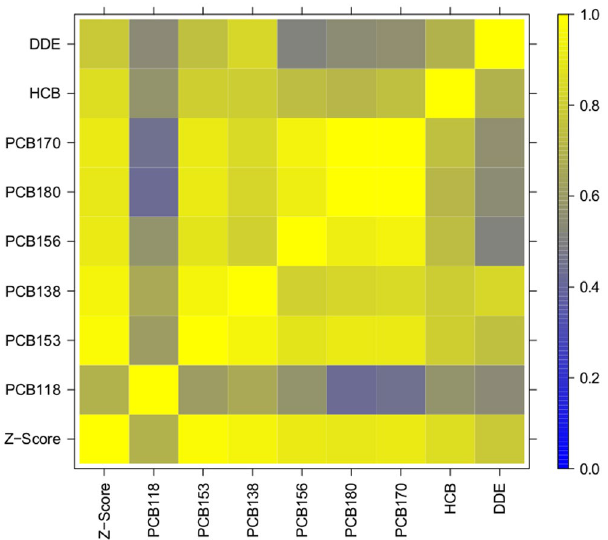
Figure 1. Pearson correlation among the eight POPs and the Z-Score. The individual levels of PCB153, PCB138, PCB156, PCB170, PCB180, HCB and DDE highly correlated with the cumulative Z-Score (r between 0.81 and 0.98). Only PCB118 showed a marginally lower correlation (r =